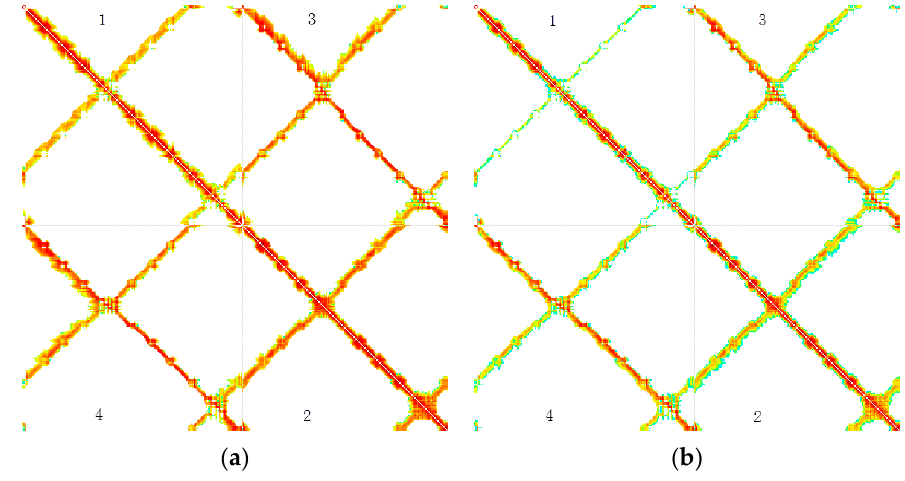
Figure 11. Match matrix graphs: ( a ) graph for tie-point extraction using GNSS and camera angles; and ( b ) graph for tie-point extraction using only GNSS information.